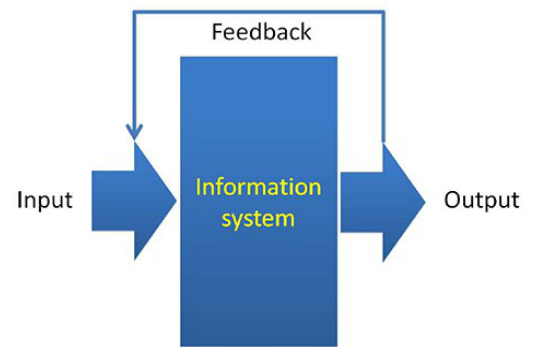
Figure 1. Information system within its